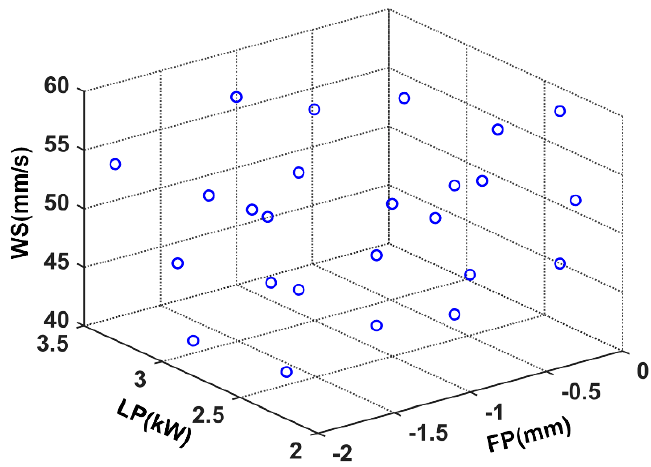
Figure 4. Spatial distribution diagram of the generated sample points. Table 2. Weld width under different process parameters.